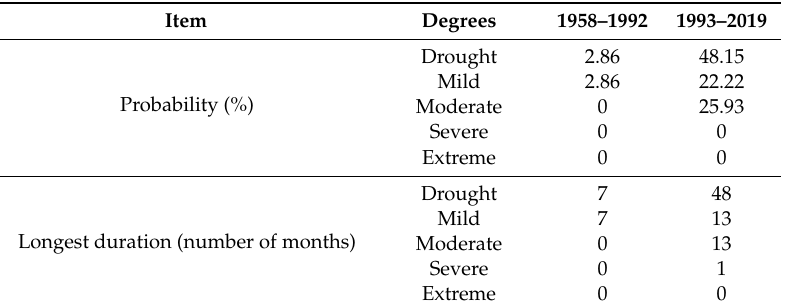
Table 2. Comparison of drought frequency and longest drought duration between 1958–1992 and 1993–2019.